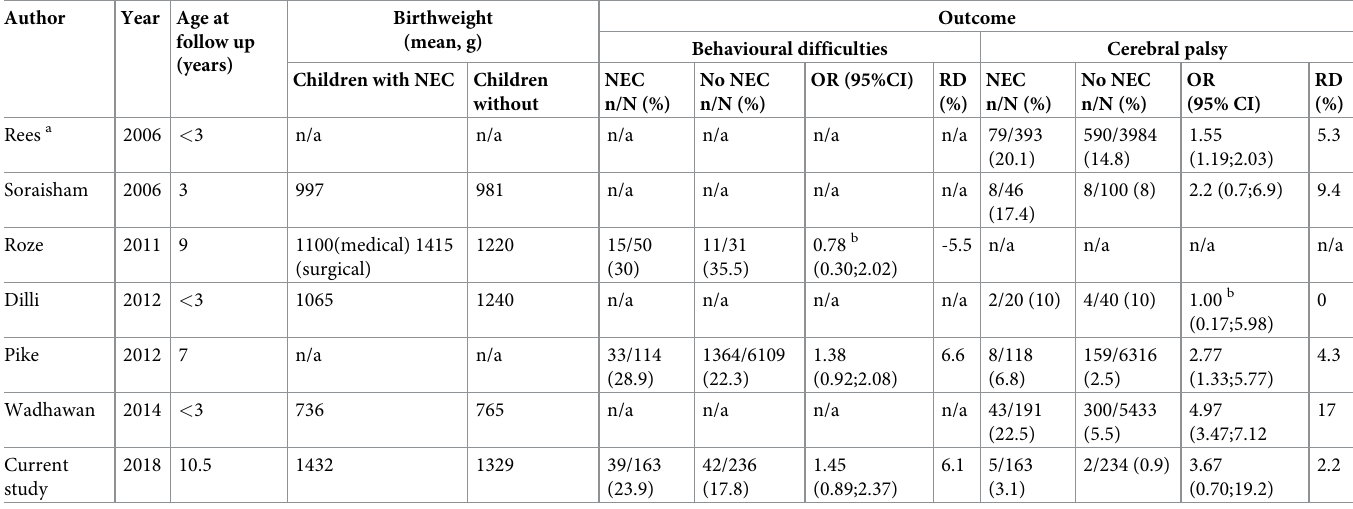
Table 6. Characteristics of behavioural and cerebral palsy studies.